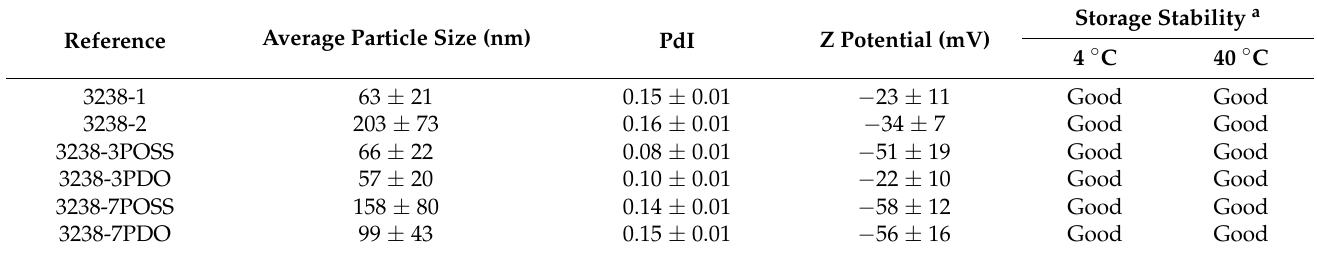
Table 6. Summary of the average particle size, PdI, and Z-potential values for synthesized WPUD dispersions. Reference